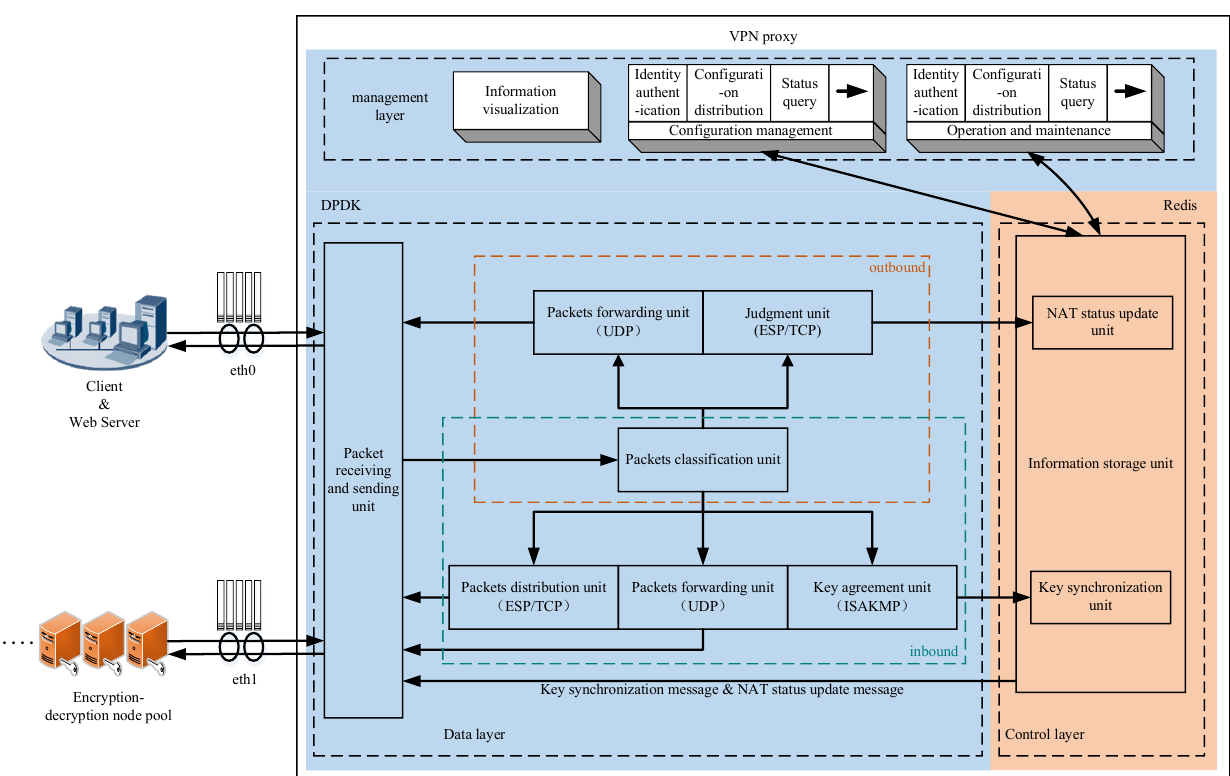
Figure 2. MVPN functional framework. (The blue part indicates that the development is based on DPDK, and the red part indicates that the development is based on